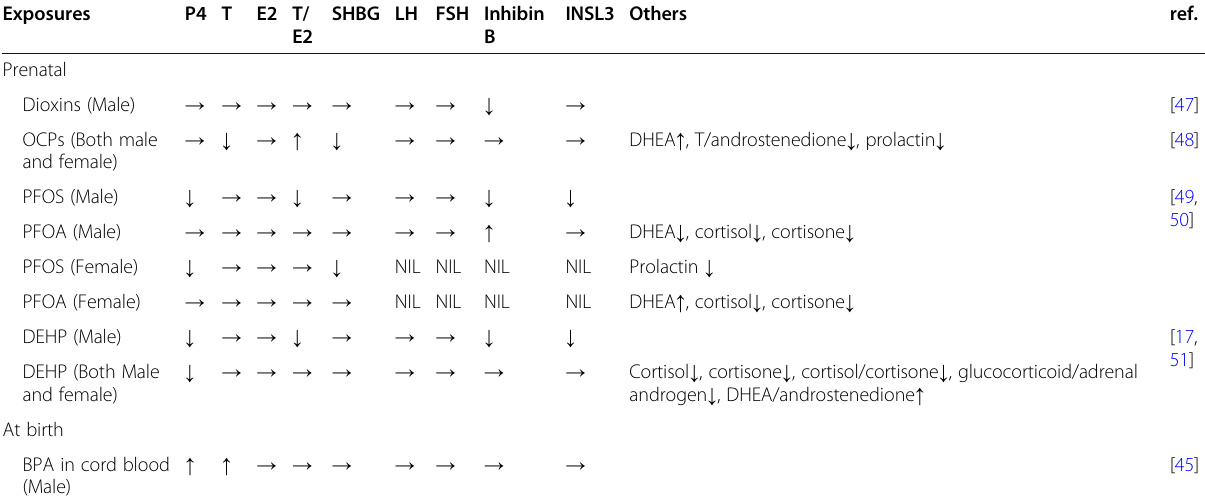
↑ / ↓ Arrows indicate the following: ↓ inversely associated ( p < 0.05); ↑ positively associated ( p < 0.05); and → no significant association. NIL indicates not examined in the study due to low detection of hormones among